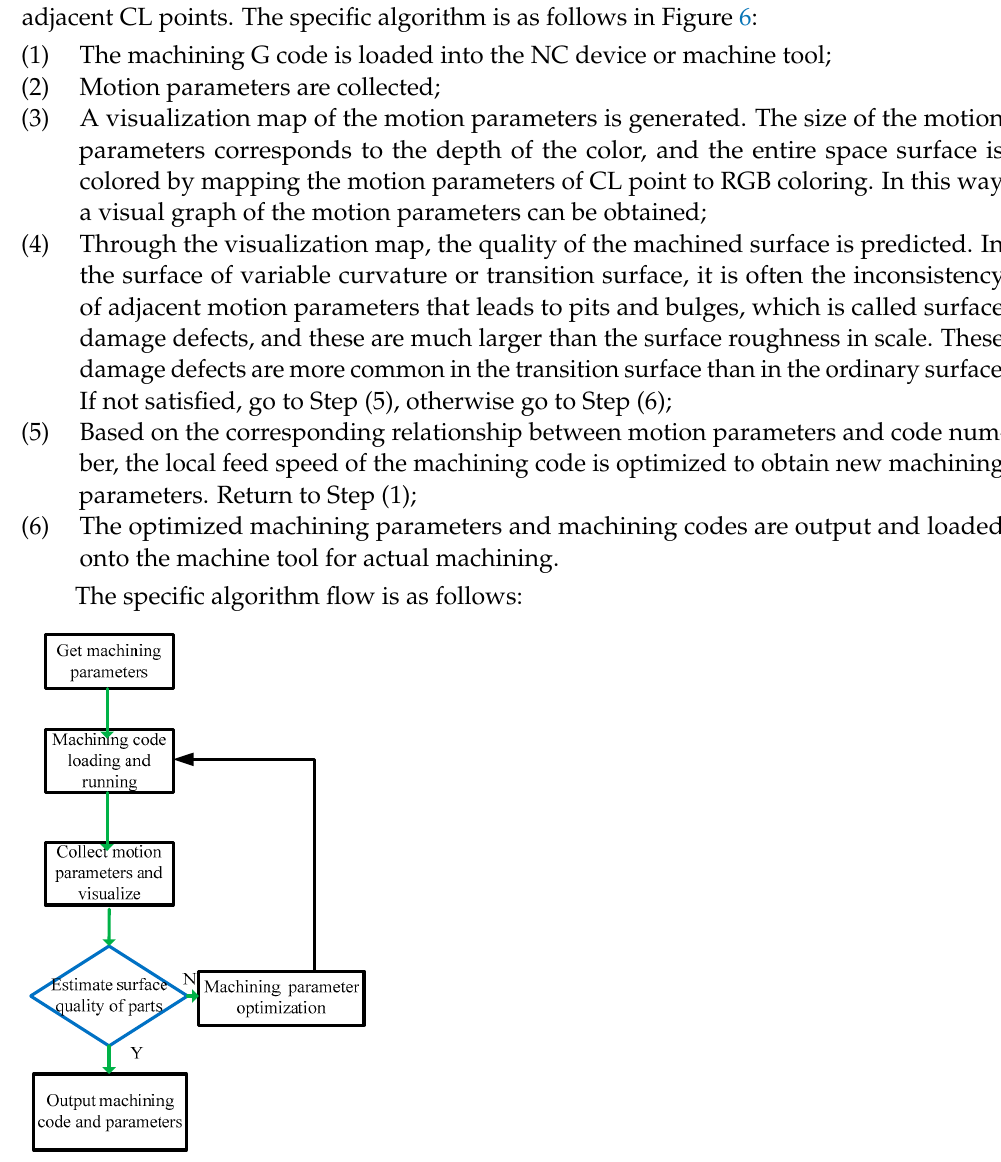
Figure 6. Surface quality prediction flowchart.